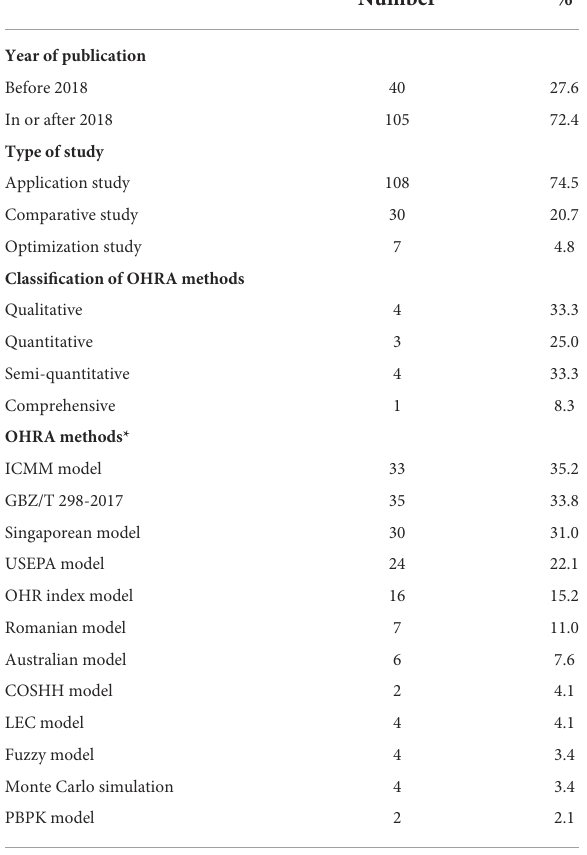
TABLE 1 General characteristics of included studies.